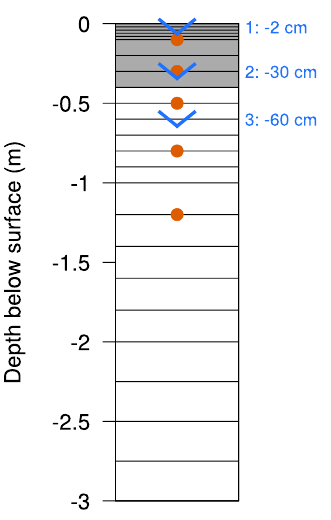
Figure 3. Soil layering as used in the Alpine3D model. The three water fluxes used to drive the hydrologic response model are shown in blue arrows. The soil moisture measurements are indicated by brown circles. The grey area is denoting the part of the soil where the initial soil saturation at the onset of rainfall or snowmelt events was determined.